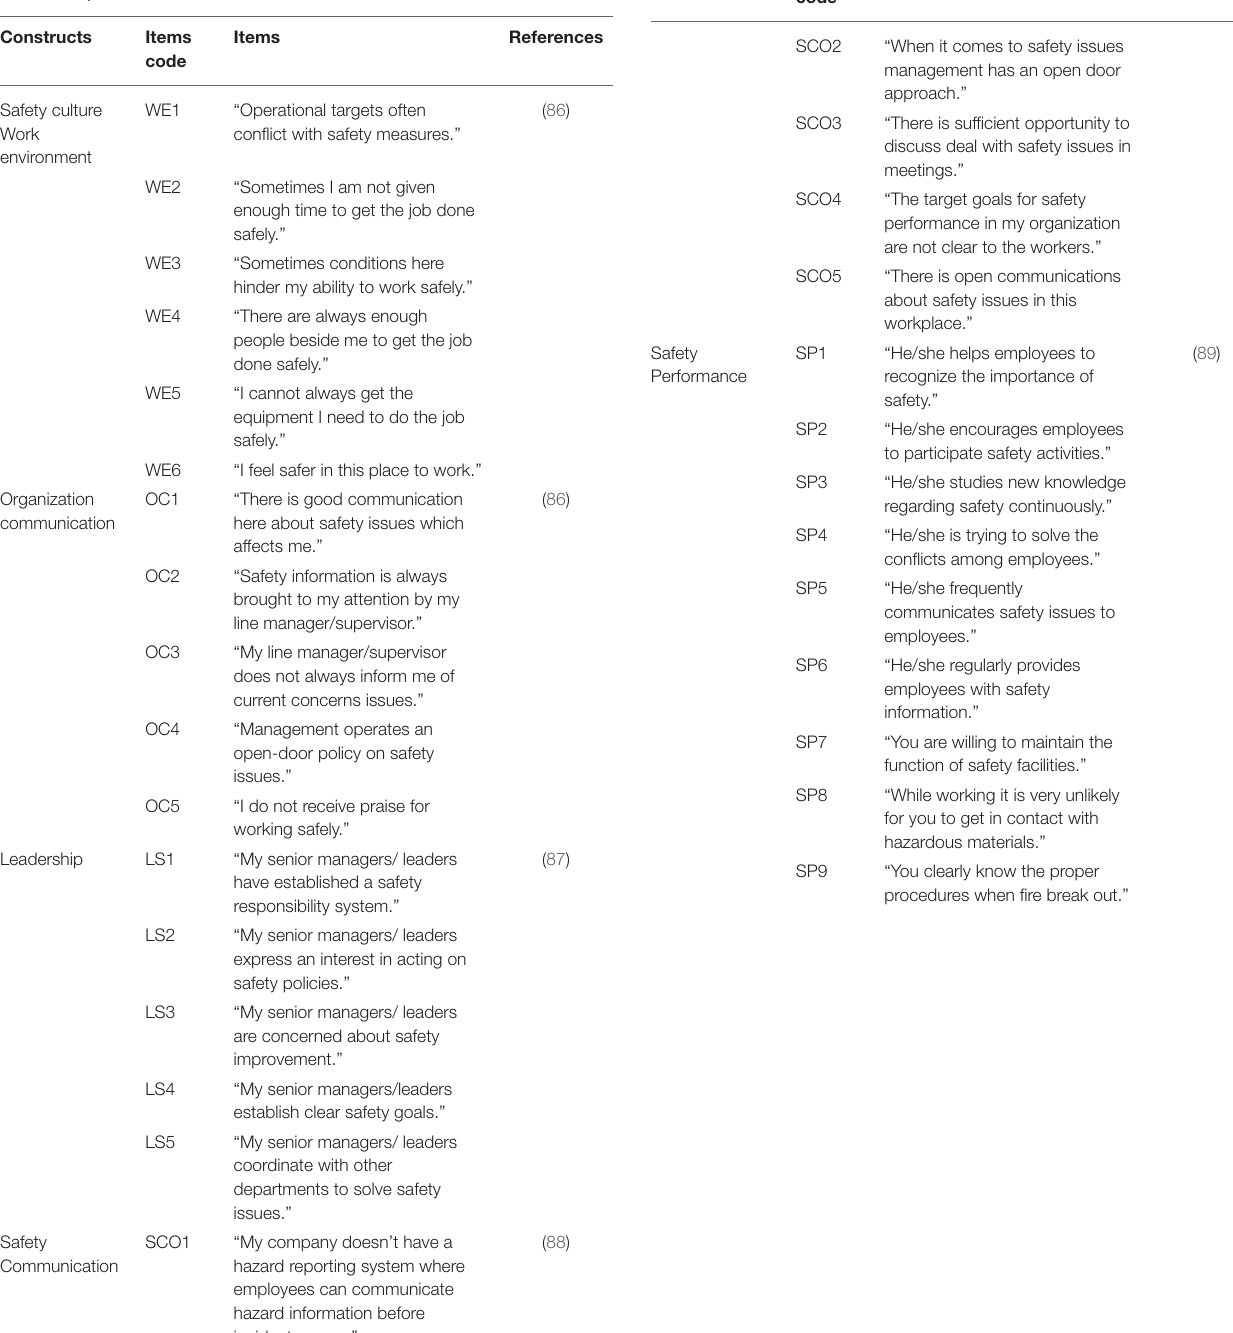
TABLE A1 | Research